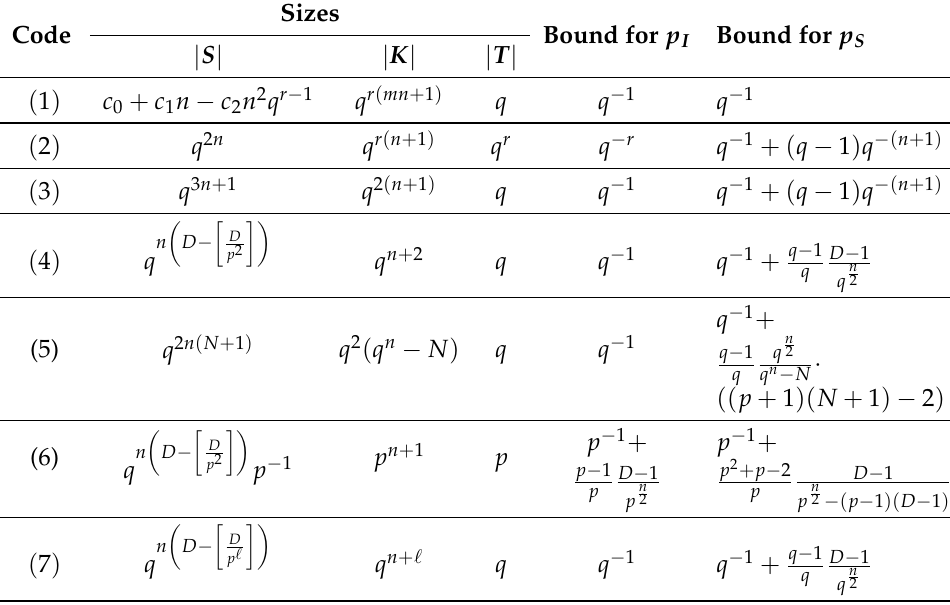
Table 2. Parameter comparison of the introduced code with other previously published codes. Sizes Code Bound for p I Bound for p S | S | | K